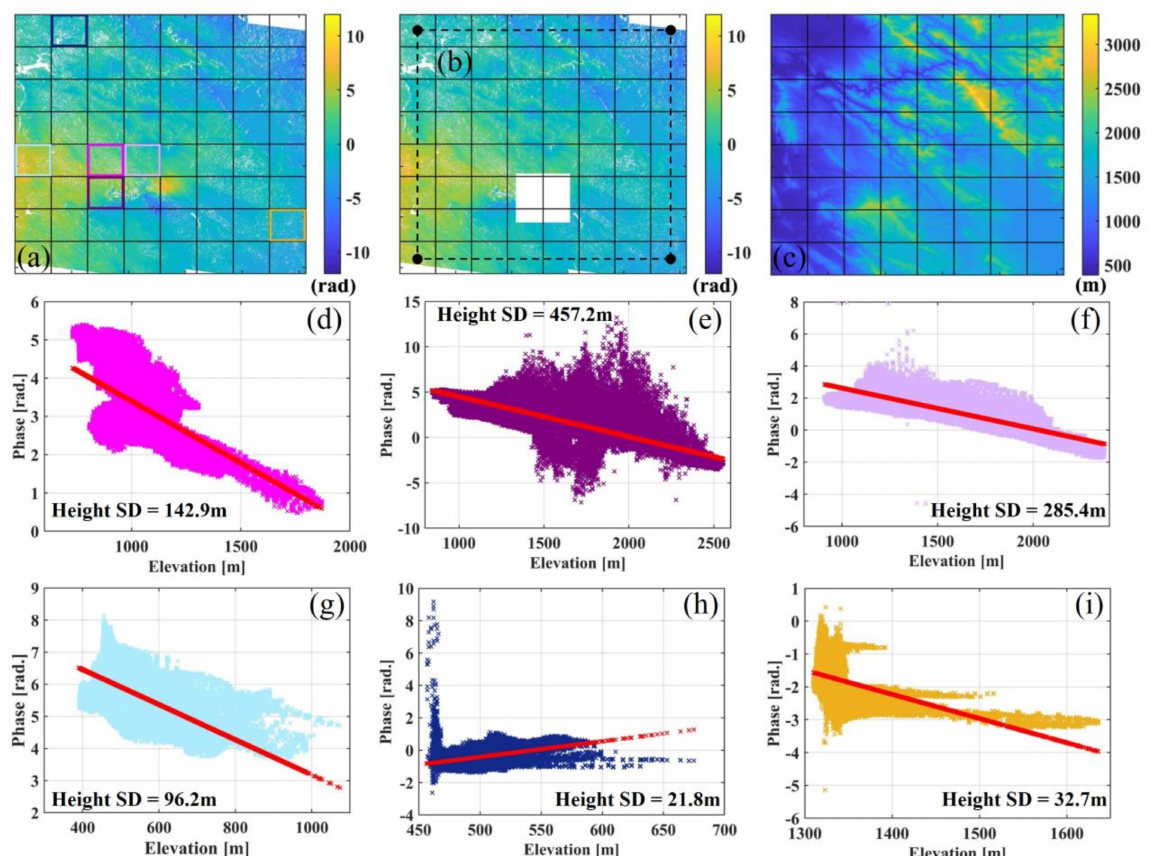
Figure 1. Demonstration of the primary ideal of the developed stratification correction scheme with the 25 August 2018, Mw 5.98 Javanrud, Iran, earthquake as an example: ( a ) is the interferogram subset with the original unwrapped phase and segmented with an 8 × 8 window; ( b ) is the unwrapped phase with coseismic zone masked; the dashed box denotes zones computed during interpolation; ( c ) is the elevation of the corresponding area; ( d – i ) are phase-elevation model examples for a single window. The red markers show the computed regression model; other colored markers denote original phase-elevation pixel pairs and they are associated with the box in ( a ) by the same